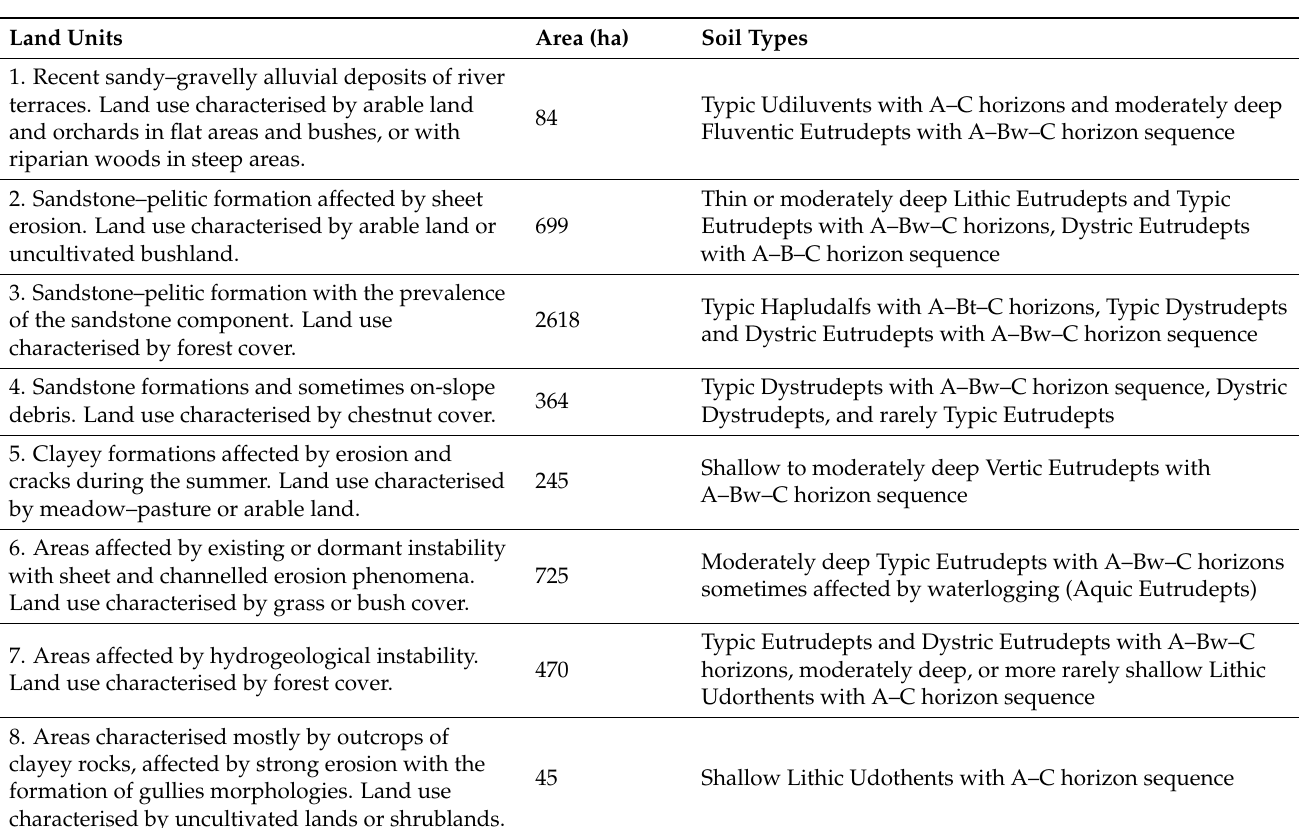
Table 1. Soil types, according to Soil Survey Staff [41], of the land units identified within Castel del Rio, Emilia-Romagna Region, Italy.